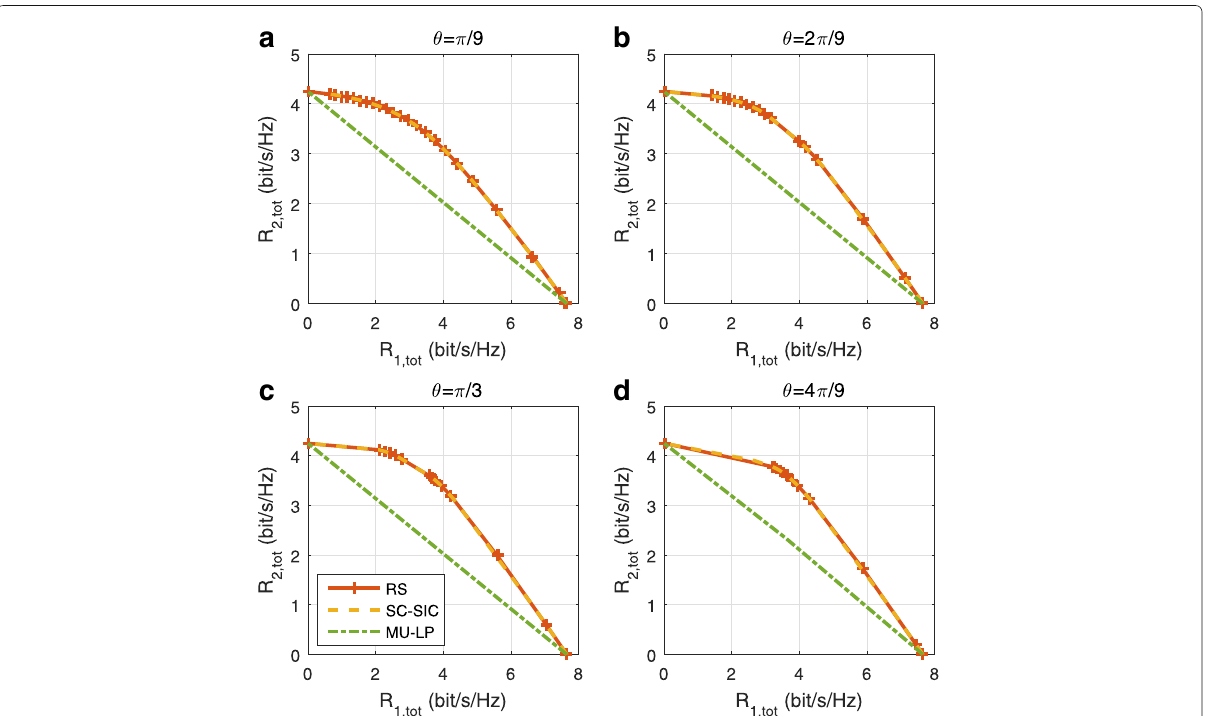
Fig. 31 Average rate region comparison of different strategies in imperfect CSIT, γ = 0.3, N t = 2, SNR = 20 dB. a θ = π/ 9. b θ = 2 π/ 9. c θ = π/ 3. d θ = 4 π/ 9